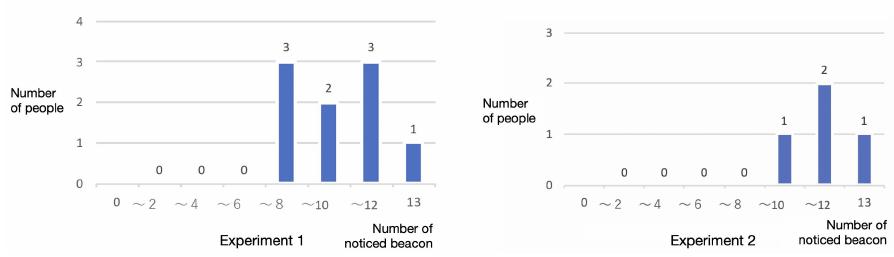
Figure 17. The number of noticed BLE